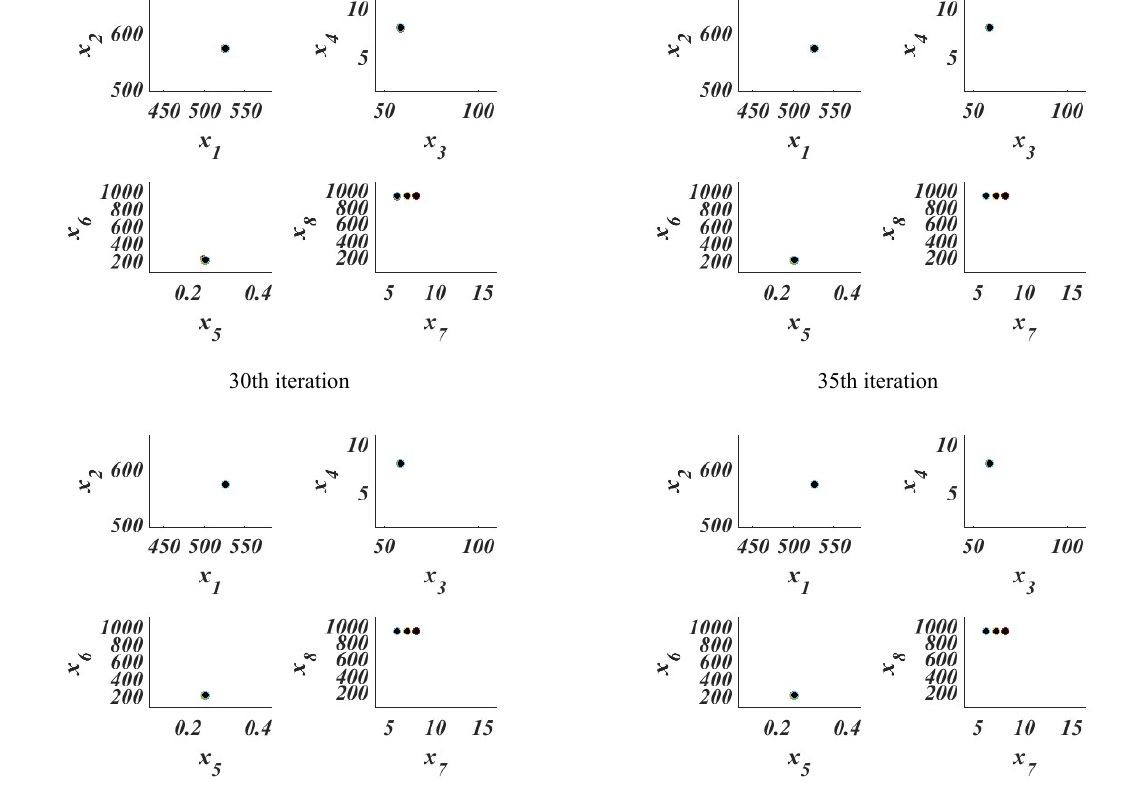
Figure 3. The movement of particles during the optimization process of the solar power plant with 13 N = and 42 M = .